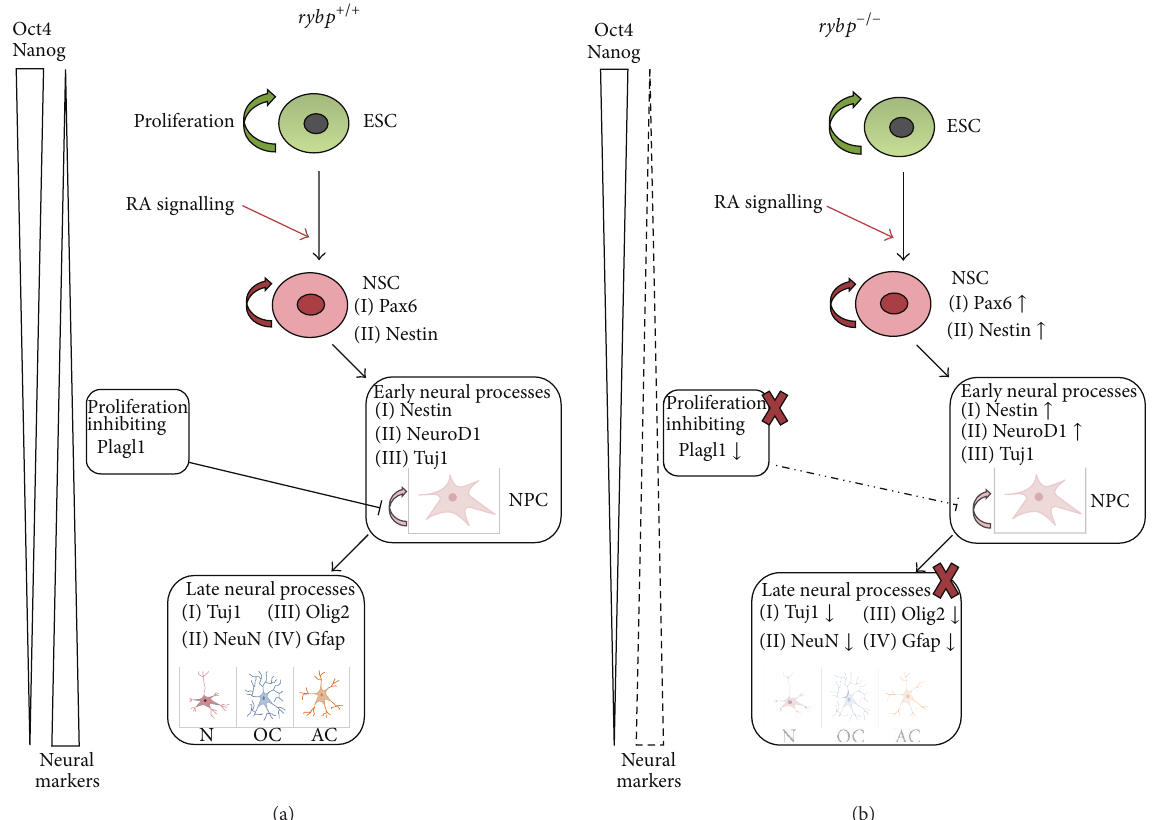
Figure 5: Model of in vitro neural differentiation in ESCs in presence and absence of Rybp. (a) Differentiation of wild type ESCs towards matured cell types of the CNS in the presence of Rybp. Pluripotent ESCs express key pluripotency markers (e.g., Oct4, Nanog) in undifferentiated state, which are gradually decreasing through in vitro neural differentiation. Parallel with this, early neural markers (Pax6, Nestin) are upregulated in NSCs, which will confer reduced proliferative and high differentiation capacity to the cells. On the other hand, in the presence of Rybp, upregulation of Plagl1 helps to facilitate late neural differentiation and inhibits cell proliferation, which will facilitate the generation of terminally differentiated neural cell types (N, OC, and AC). By the progression of neural differentiation, NPCs will differentiate further and start to express markers of specialized neural cell types (Tuj1, NeuN, Olig2, and Gfap). (b) Differentiation of pluripotent ESCs towards matured cell types of the CNS is impaired in the absence of Rybp. During neural differentiation early neural markers (Pax6, Nestin) exhibit elevated expression level in the rybp null mutants. These will facilitate the generation of a bigger pool of NPCs with higher proliferative capacity. On the other hand, in the absence of Rybp, Plagl1 expression is defective, which also contributes to increased proliferative and decreased differentiation capacity of the NPCs. As a result, the formation of terminally differentiated neural cell types (N, OC, and AC) will be impaired in the lack of functional Rybp. ESC: embryonic stem cell; NSC: neural stem cell; NPC: neural progenitor cell; N: neuron;